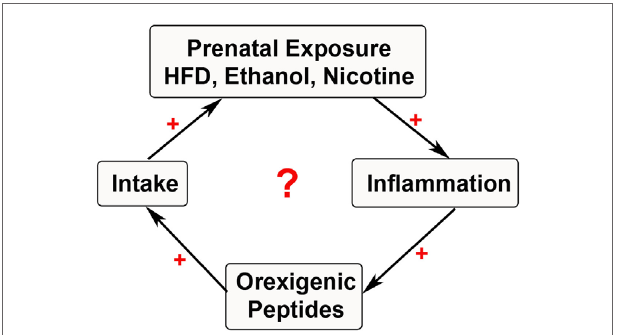
FiGURe 1 | Cycle of substance exposure . The schematic depicts the current hypothesis of a simplified positive feedback loop involving prenatal exposure to substances of abuse that stimulate inflammatory systems. This inflammation may be involved in stimulating neuropeptides that further increase ingestive behavior, thus leading to a cyclical increase in exposure during the prenatal period with negative outcomes in the offspring.